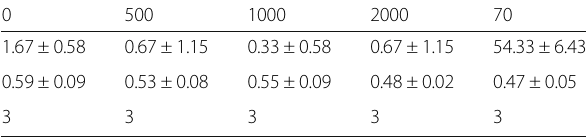
Table 5 Results of micronucleus assay in male mice